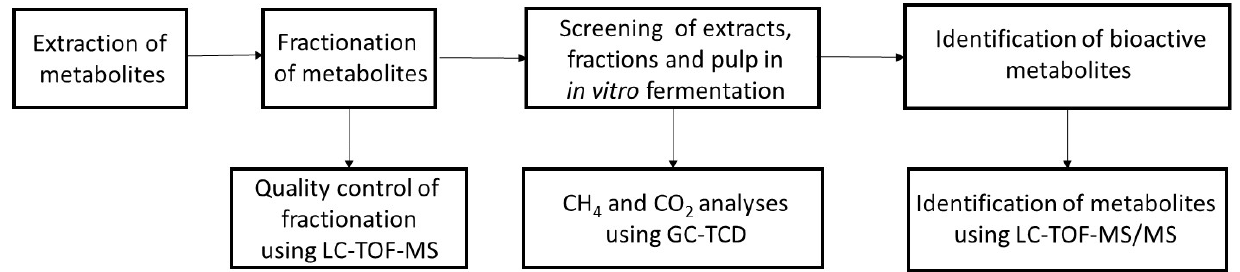
Figure 1. Schematic representation of the experimental design.